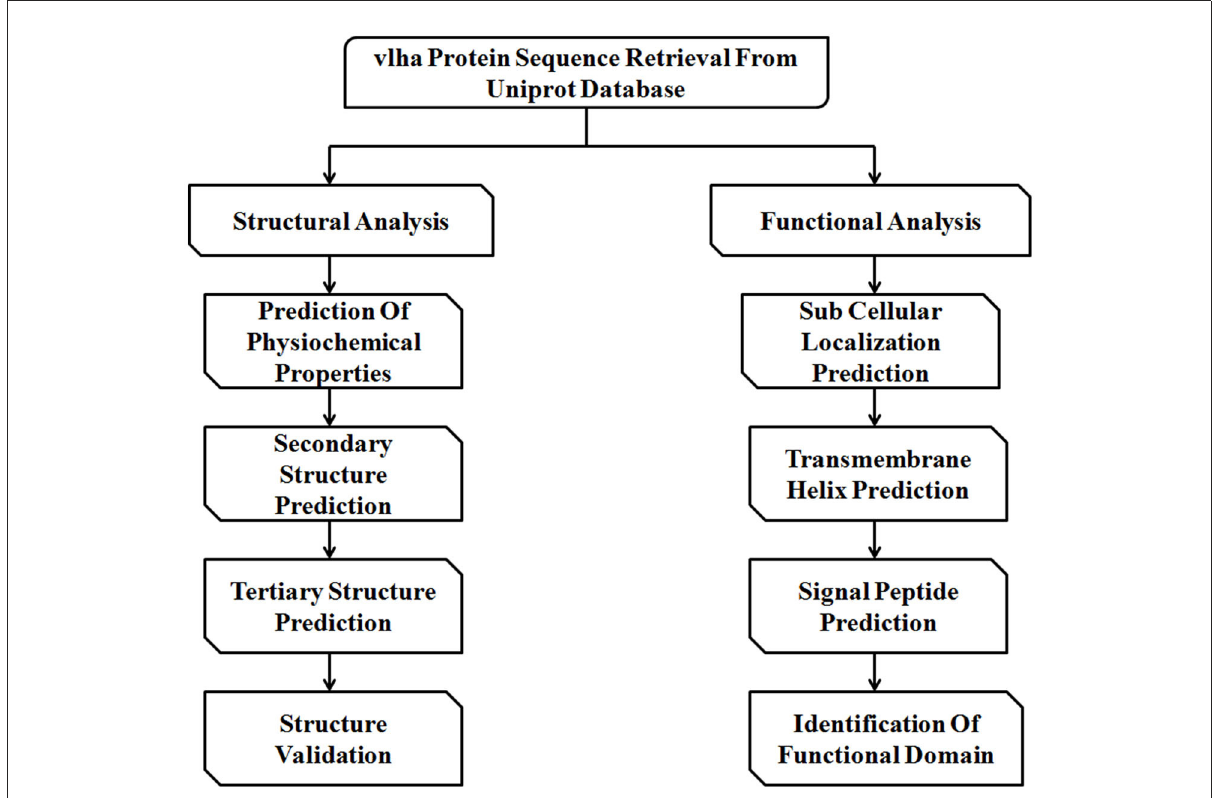
FIGURE1 Schematic representation of the workflow followed in this